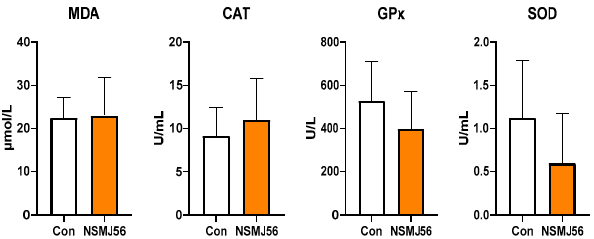
Figure 1. Changes in the antioxidant capacity by NSMJ56 feeding. Broilers were fed the control diet or NSMJ56-containing diet for 10 days. Total MDA and antioxidant enzyme (CAT, GPx, SOD) activity in sera were analyzed. Data were obtained from the control group ( n = 6) and NSMJ56 group ( n = 6) and presented as means ± SD. The significance differences between the control and NSMJ56 groups were analyzed using a two-tailed unpaired t -test or a Mann–Whitney